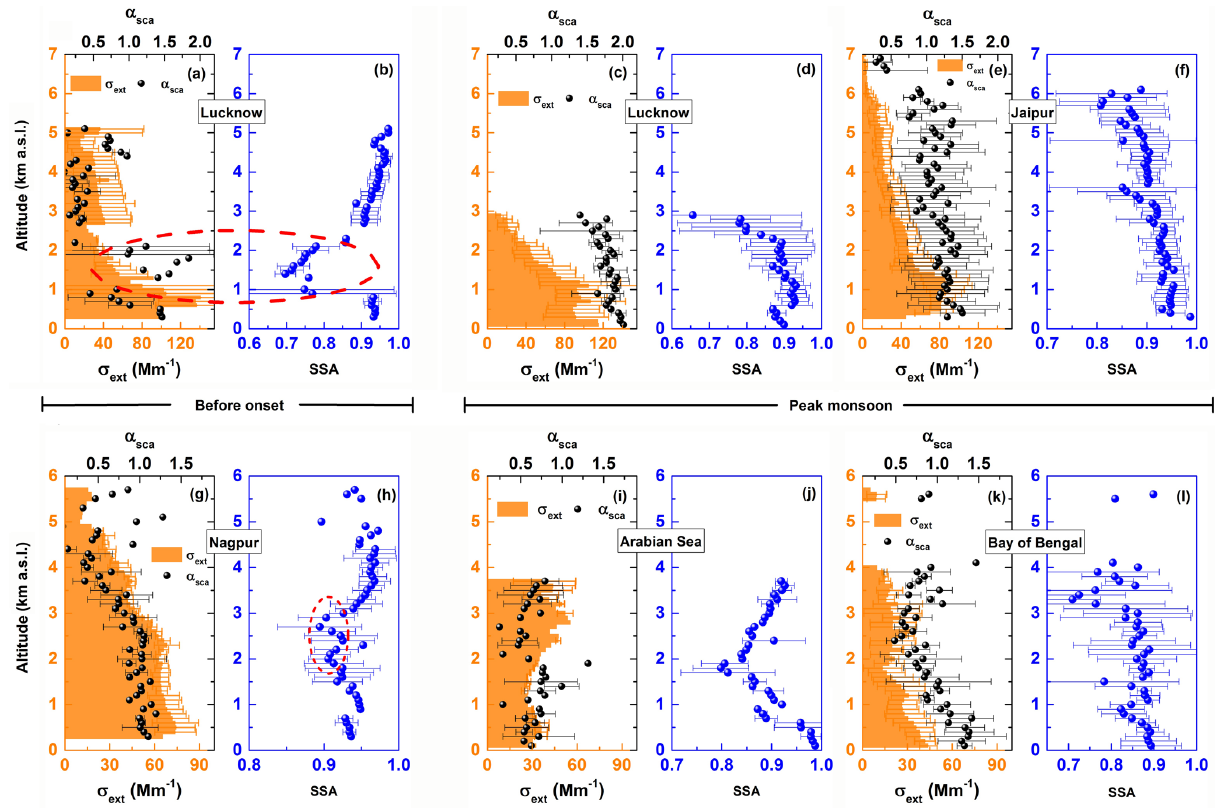
Figure 3. The vertical distribution of extinction coefficients ( σ ext ) and single scattering albedo (SSA) and the vertical distribution of scattering Ångström exponent ( α sca ) during the SWAAMI campaign are shown for five locations: Lucknow, Jaipur, Nagpur, Arabian Sea and Bay of Bengal. Data for both the pre-monsoon ( a and b ) and monsoon ( c and d ) periods are available only for Lucknow. The data available from Bhubaneswar were limited due to instrument failure during the pre-monsoon (Phase 1), and there were only poor data quality during the monsoon (Phase 3); these are hence not included in the